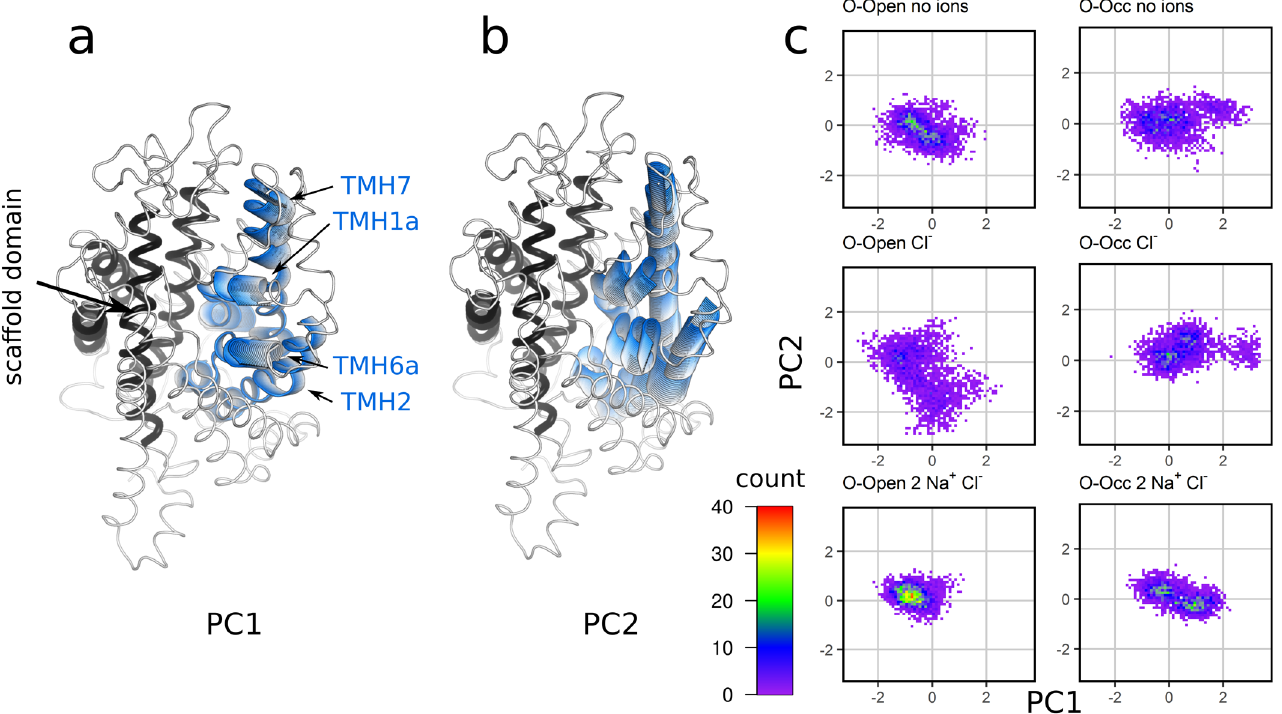
Figure 6. Principal component analysis indicates the reduced dynamics of the bundle domain. Visualization of the hSERT movements captured by principle component 1 (PC1) ( a ) and PC2 ( b ) shown as a series of intermediate conformations interpolated between the two most extreme conformations observed in the simulation of the O-Open Cl − -bound system. ( c ) Projection of the motions of the hSERT onto PC1 and PC2. The motions of the bundle domain (Cα atoms) were analyzed after fitting to the scaffold domain. The analysis included all trajectories with a time resolution of 1 ns. PC1 described 39% of the total variance, and PC2 described 20% of the total variance.